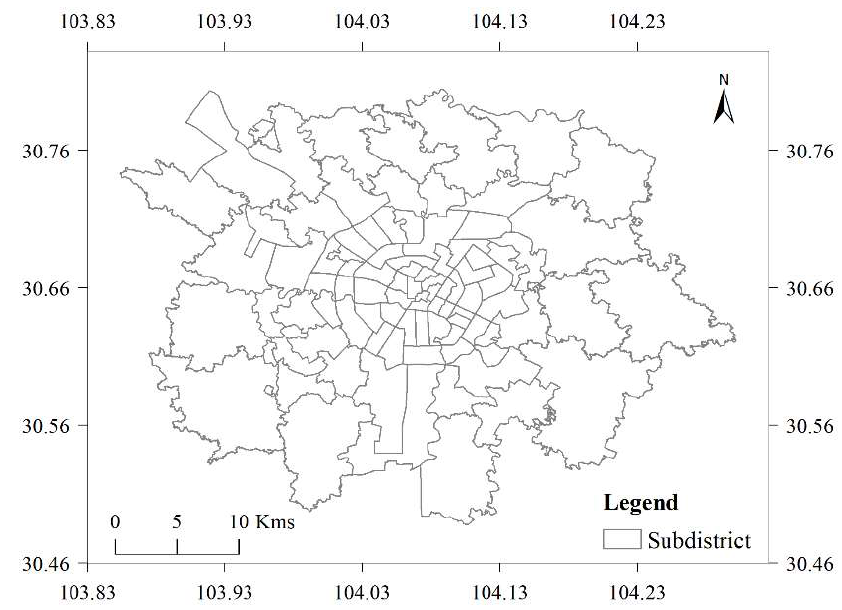
Figure 1. The study area map.